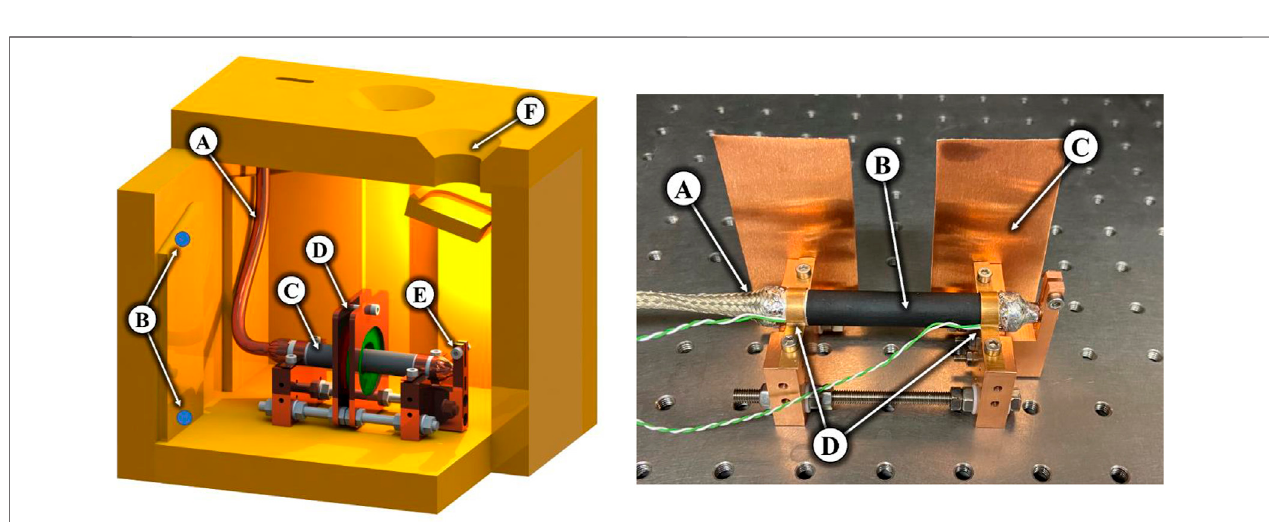
FIGURE4| BSCCOcurrentlead.Left:CADdrawingofthesuperconductingcurrentleadinsidethecryo-boxwithacoaxialpowerfeedclampedtoacoppermount that increases thermal mass for prolonged measurement times and dissipates heat to the solid nitrogen. (A) Coaxial wire; (B) Liquid level indicators with two K-thermocouple; (C) BSCCO current lead; (D) Permanent magnet mount; (E) Copper mount; (F) Liquid nitrogen inlet. Right: Manufactured setup with the BSCCO current leadclamped to the copper mount and thermocouples attached toeach end ofthe superconductor. (A) coaxialwire connection; (B) BSCCO current lead; (C) copper fi ns; (D) thermocouple